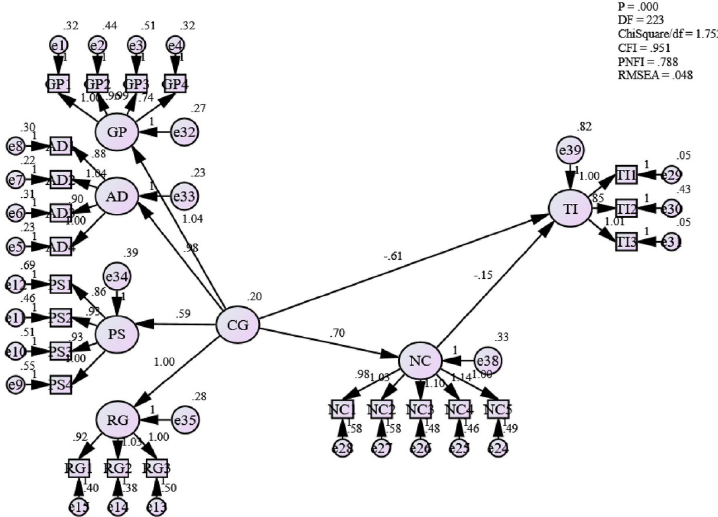
Fig 11. Mediating effect of normative commitment between career growth and turnover intentions.